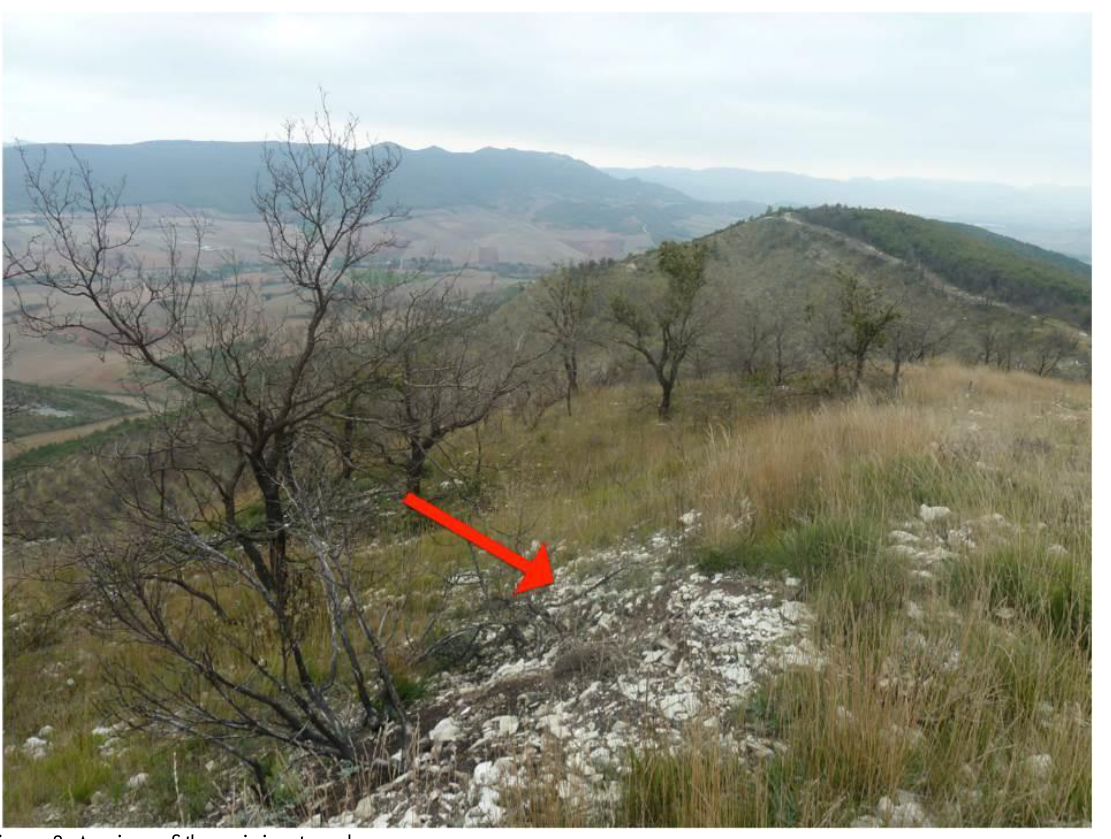
Figure 8. A view of the mining